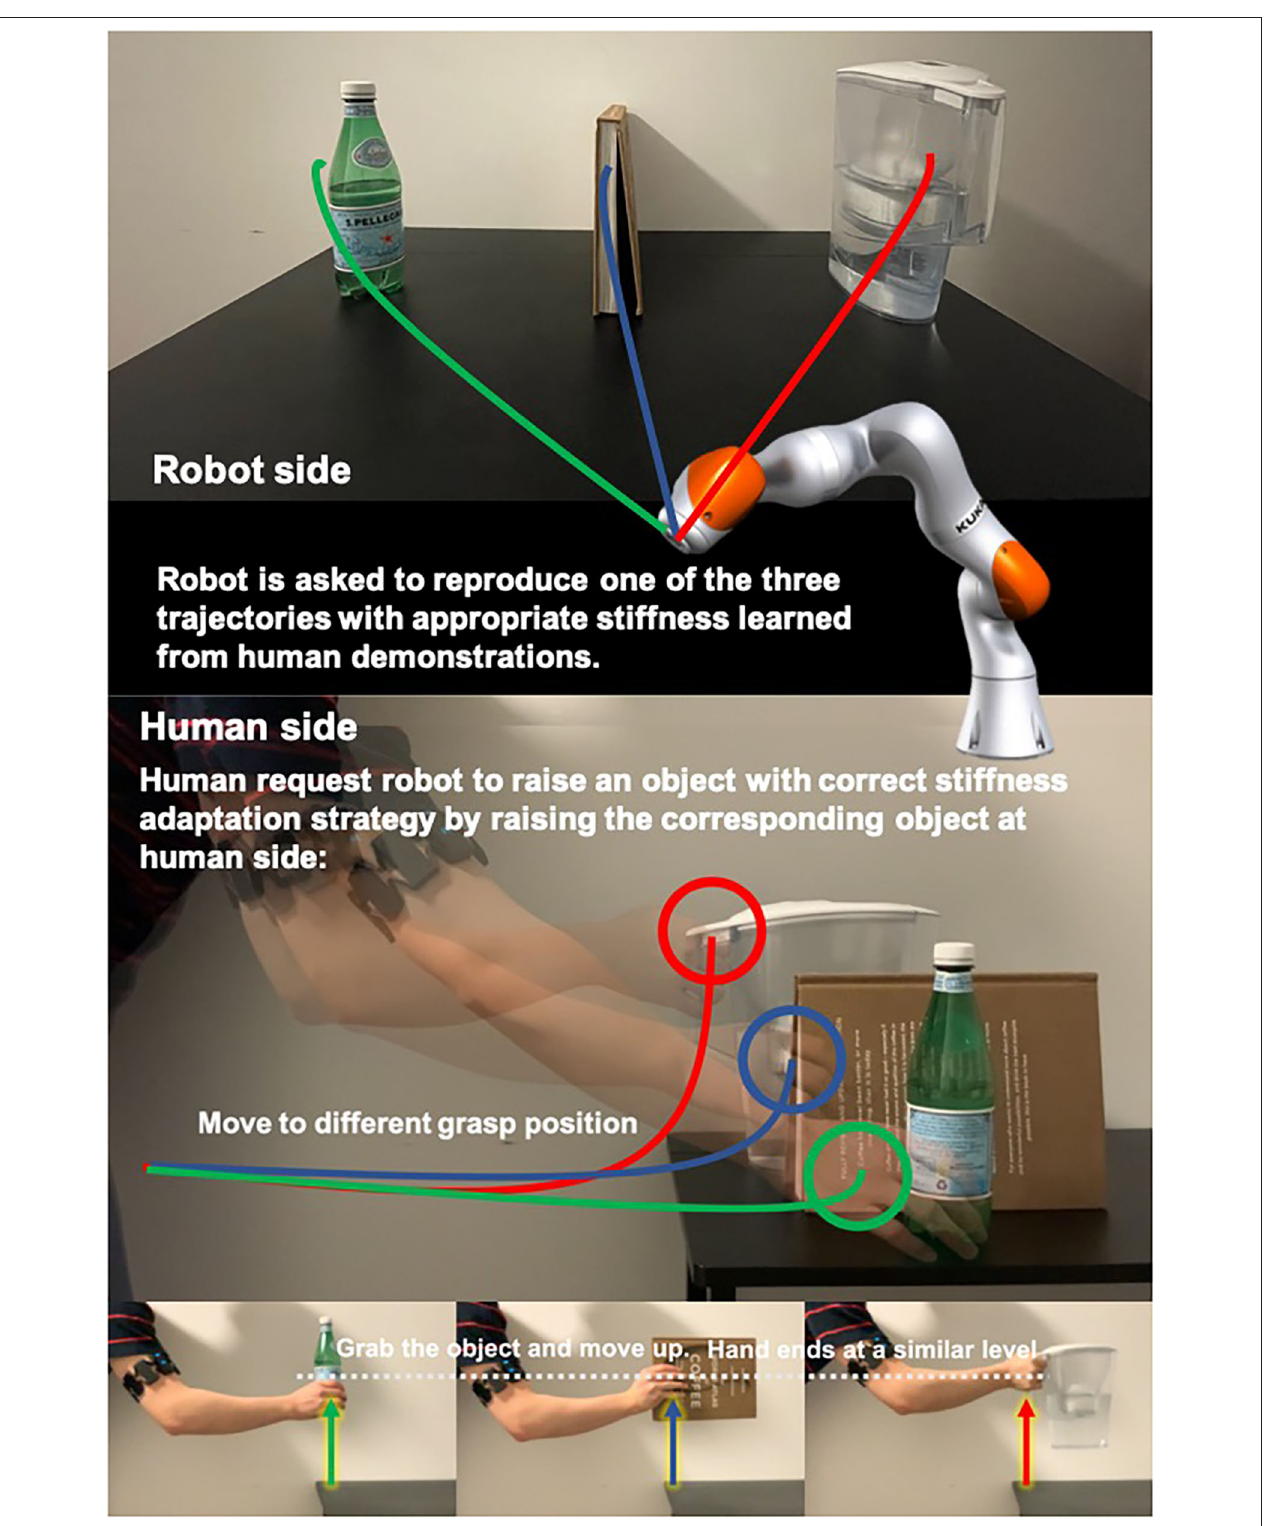
FIGURE 9 | Illustration of the object matching